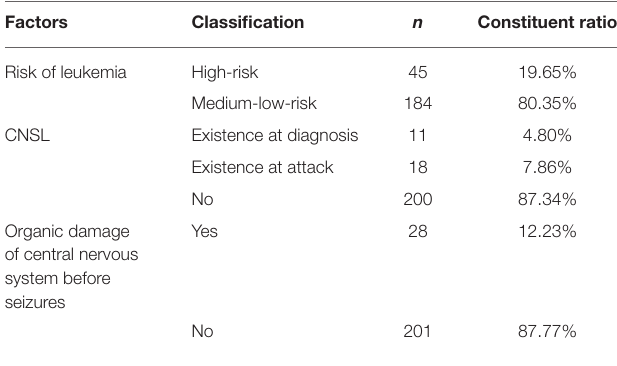
TABLE 2 | Factors of primary epilepsy